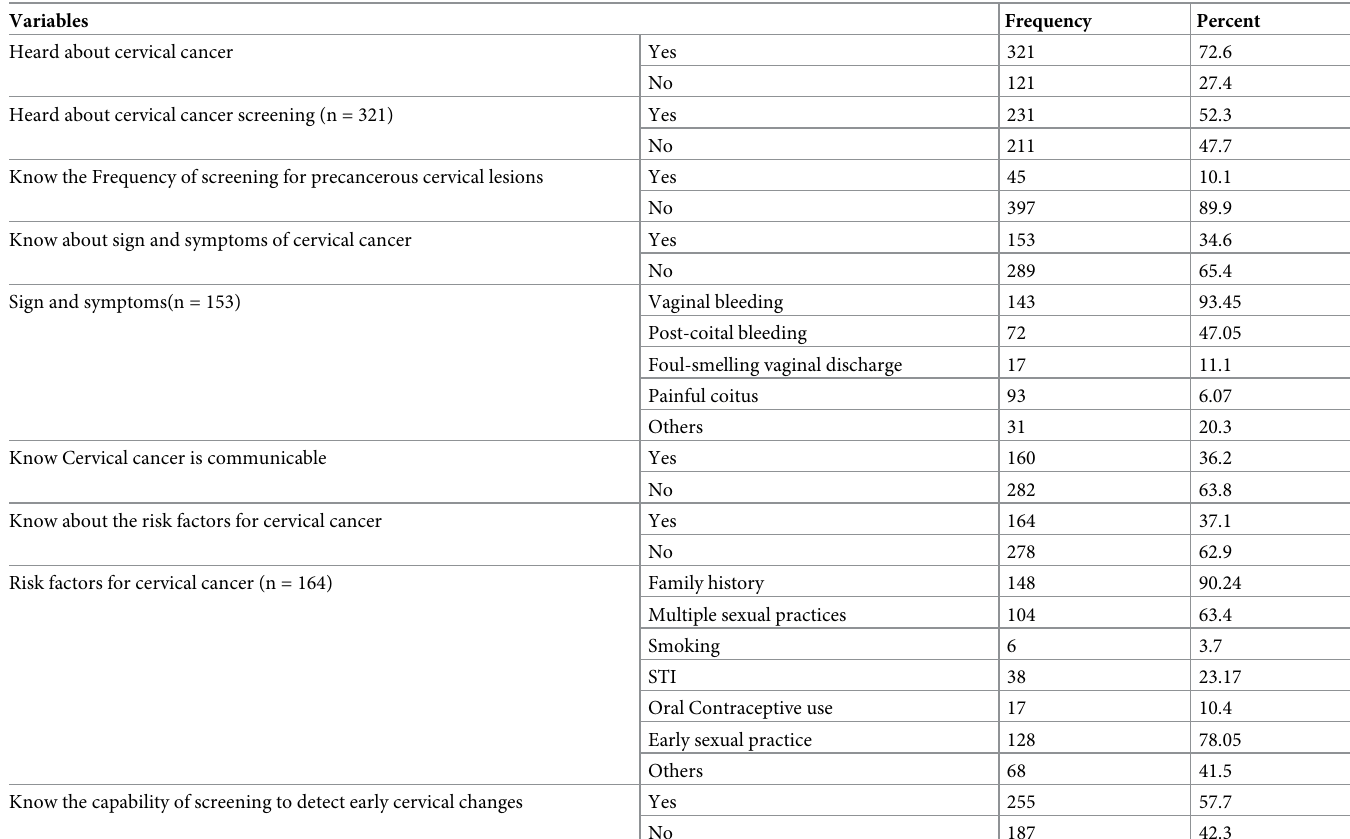
Table 2. Knowledge of females (15–49 years) about cervical cancer and its screening service in Durame Town, SNNPR, Ethiopia, 2020 (n =